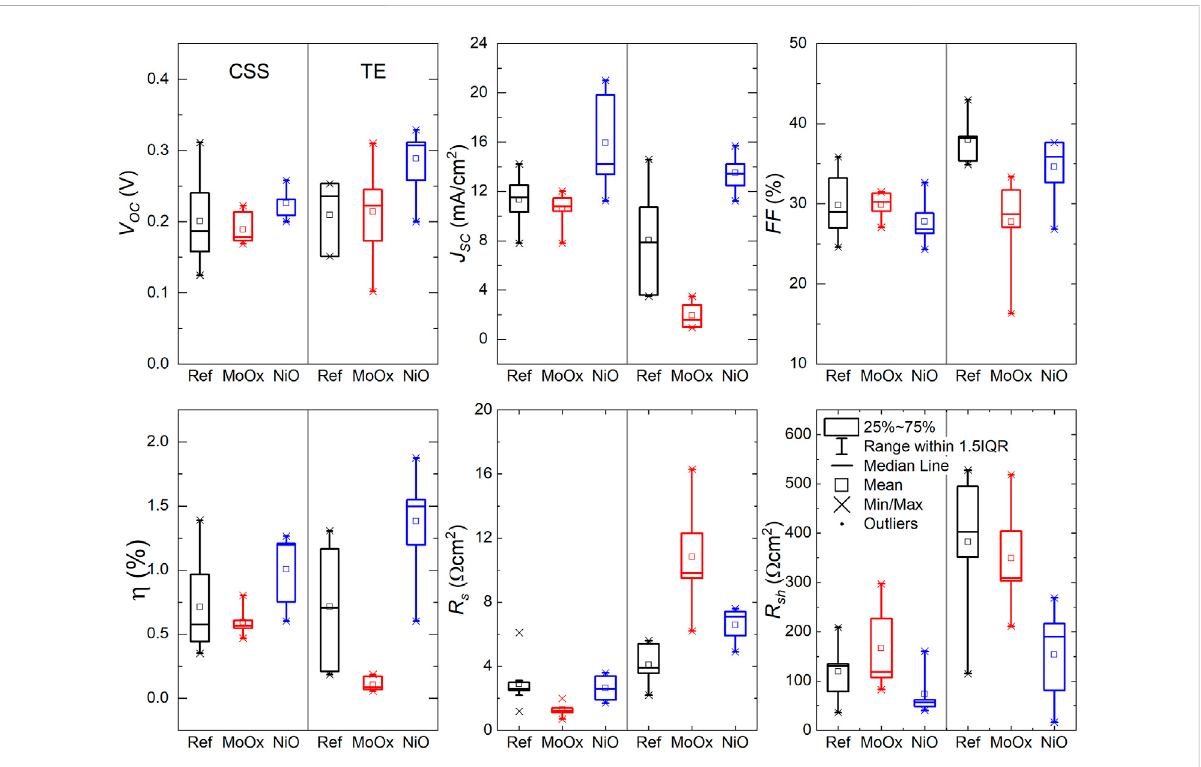
FIGURE 8 □ is the average value and × is the minimum J-V parameters of superstrate TE and CSS Sb 2 Se 3 devices with incorporated MoO x and NiO HTLs. and maximum position. The three horizontal lines of each box stand for the 25%, 50%, and 75% of the reading distribution. The whisker range is determined by the standard deviation of the sampled devices. IQR is the inter-quartile